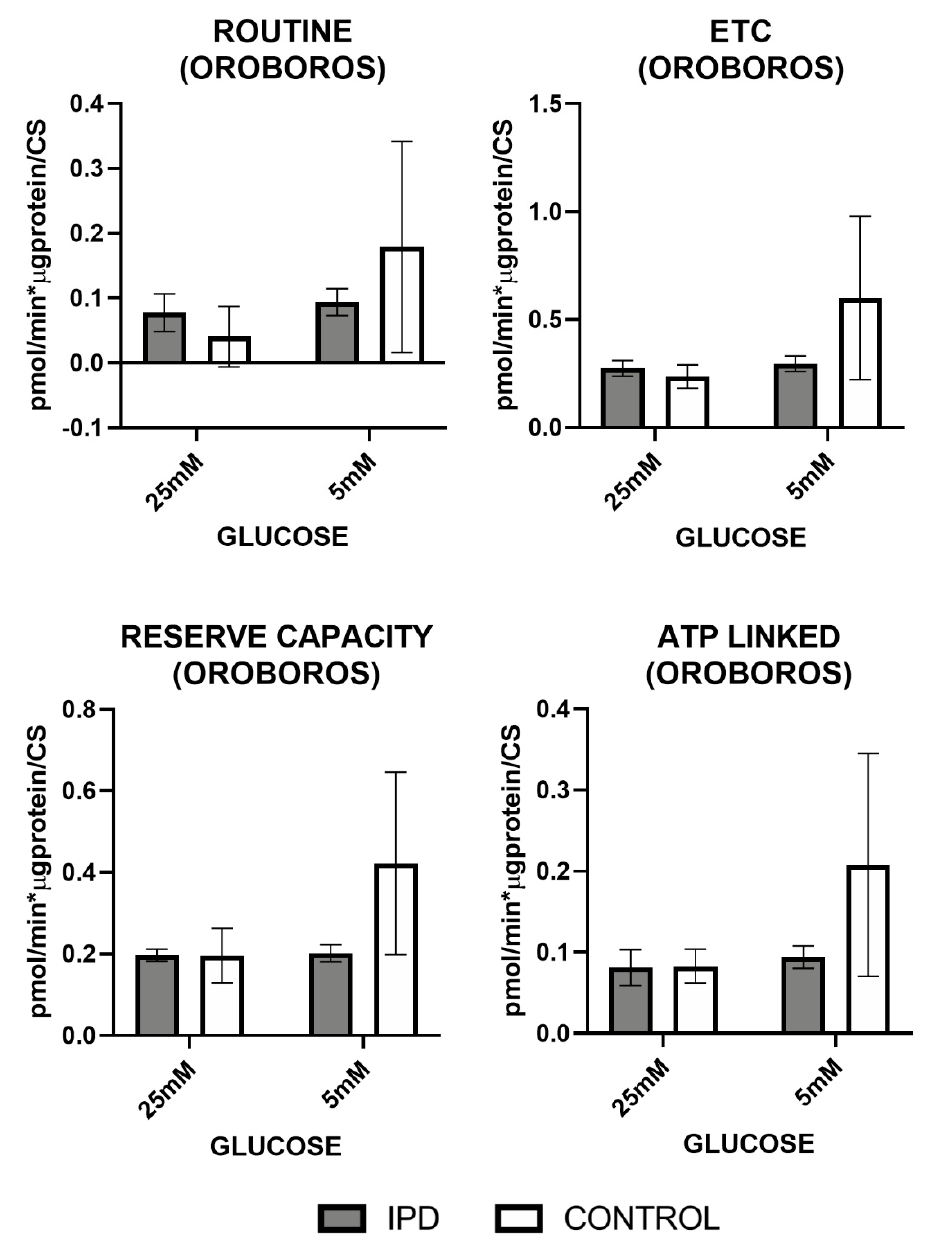
Figure 4. Mitochondrial oxygen consumption by Oroboros technology in fibroblasts of iPD patients vs. controlsexposedtoloworhighglucoseconcentration(5vs. 25mM).Mitochondrialrespirationmeasured through the Mitostress test and Oroboros TM technology confirmed decreased mitochondrial activity in fibroblasts from idiopathic Parkinson’s disease patients (iPD, gray bars) vs. controls (C, white bars), which additionally showed reduced mitochondrial plasticity with respect to controls to adapt to di ff erent glucose conditions. ETC: electronic transport chain capacity; ATP: adenosine